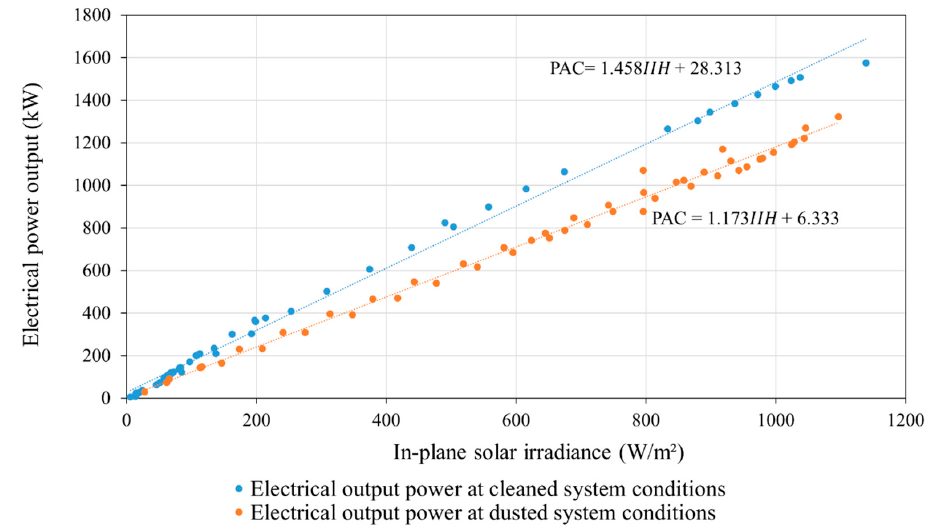
Figure 7. Global solar irradiation versus electrical power for the PV plant.